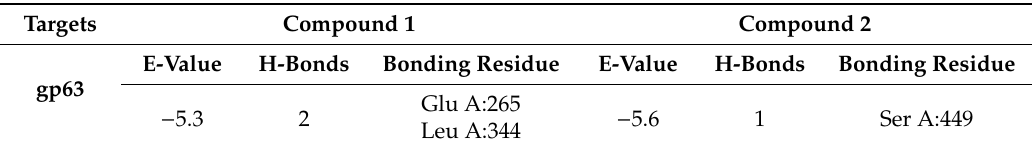
Table 1. E-value (kcal / mol) and post-docking analysis of best pose of compound 1 and 2 with GP63